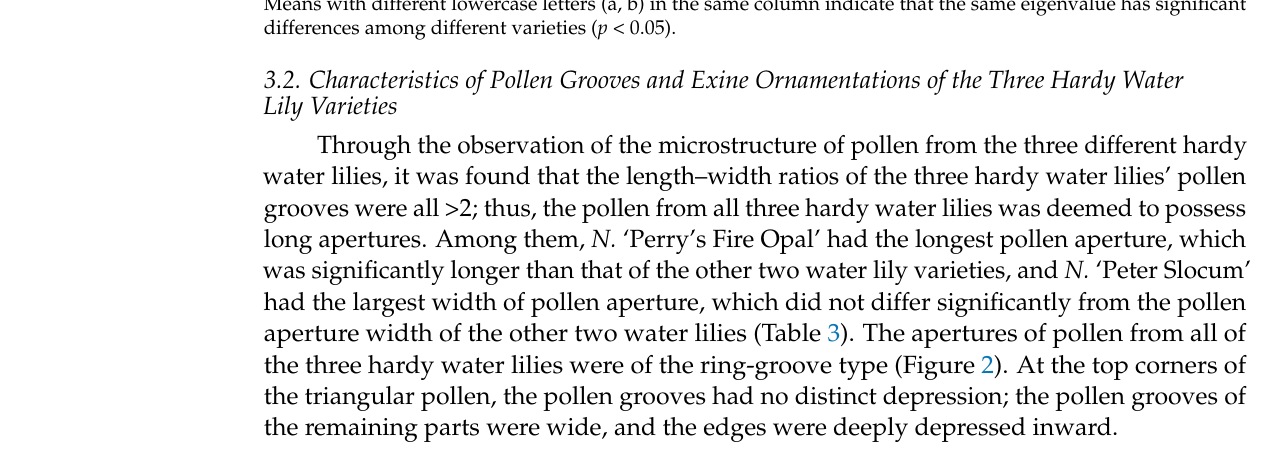
Table 3. Pollen groove characteristic values of the three hardy water lily